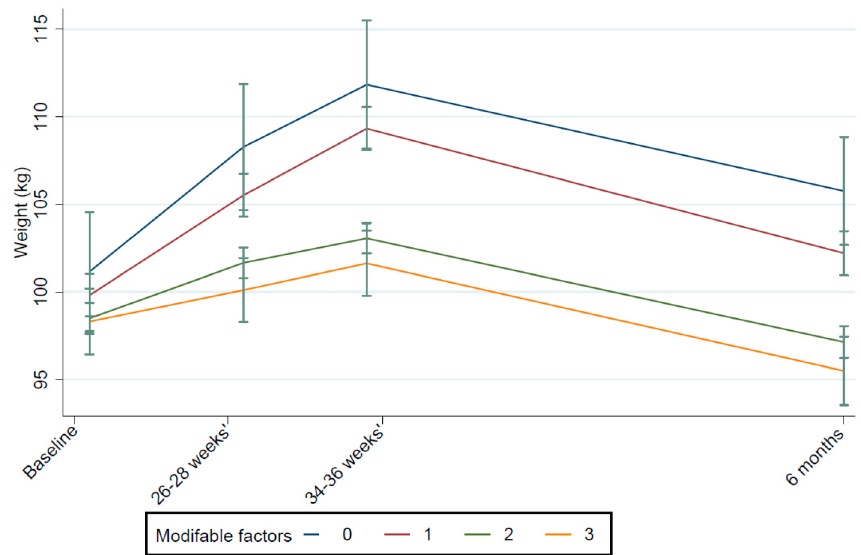
Figure 2. Mean weight from baseline to 6 months postpartum for women with zero, one, two, or